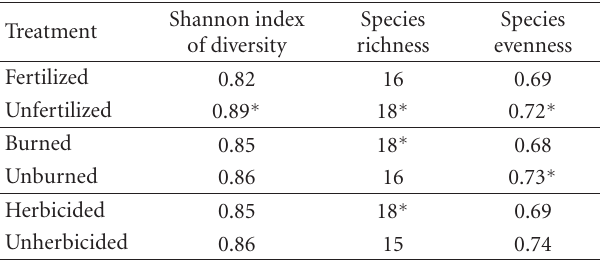
Table 4: Main treatment e ff ects on alpha diversity at combined cherokee ridge and sweet union research sites, east Texas, USA. ∗ significantly higher at P = .1 from other treatments within column from analysis of various test proc GLM (SAS, ver